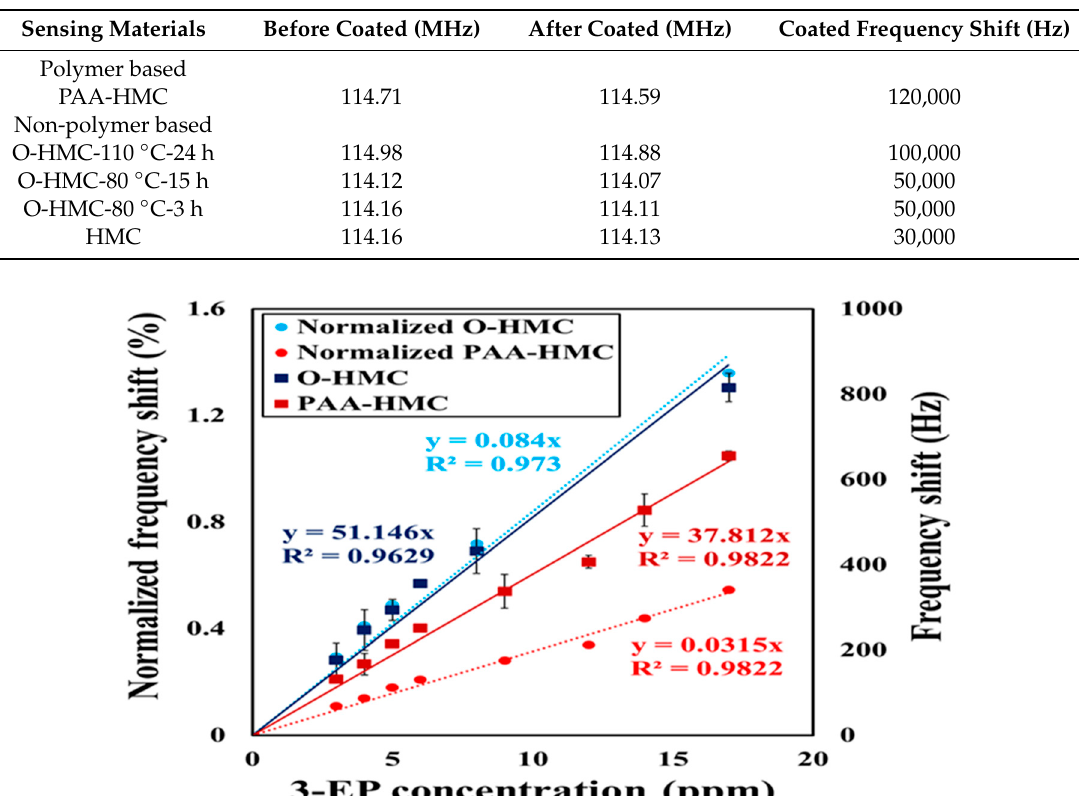
Figure 6. Frequency shift (deep blue and deep red) and normalized frequency shift (blue and red) of sensing materials O-HMC, polyacrylic acid, and hollow mesoporous carbon nanospheres (PAA-